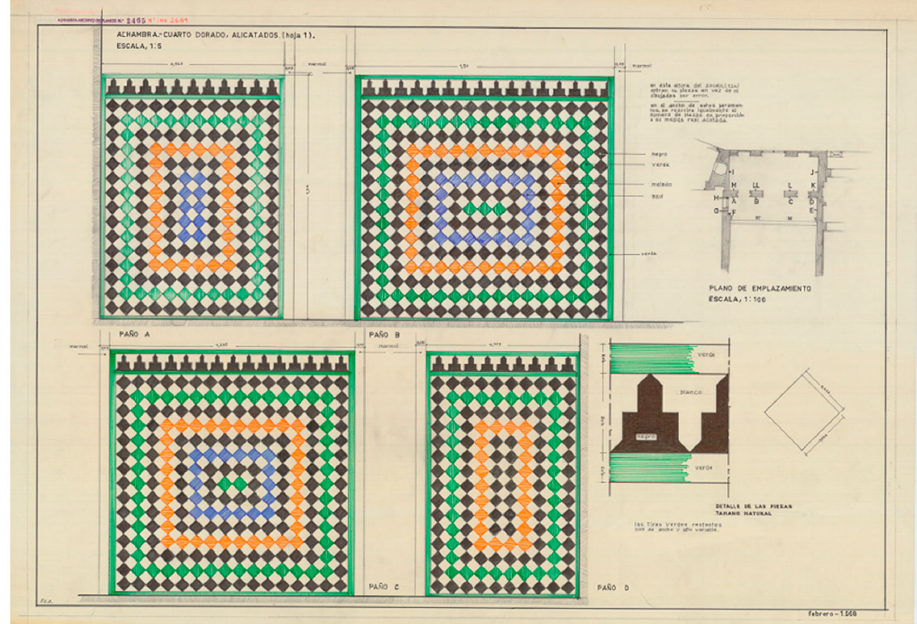
Figure 32. Drawings and layout plan of the ceramic dadoes on the south, east and west walls of the Cuarto Dorado. Fernando L ó pez D í az de la Guardia, February 1968. © Archivo del Patronato de la Alhambra y Generalife, Photograph Collection, P-002681.